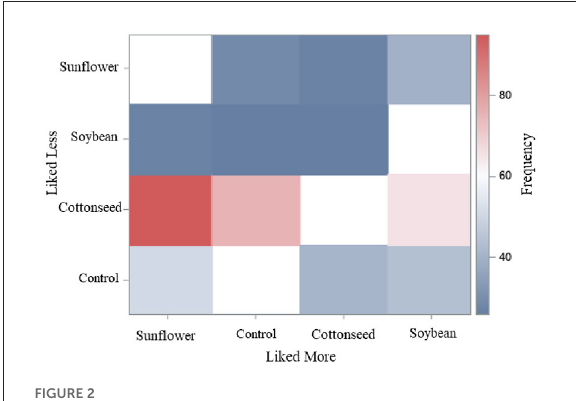
FIGURE2 Heat map with the frequency of responses from judges for global acceptance on sensory analysis of burgers. In the blind test, judges answered which sample liked more and liked less between burgers of steers without or with different oilseed grains sources in diet: control, soybean, cottonseed, and sunflower. The frequency of combined responses among liked more ( x ) and liked less ( y ) is represented by the intensity of colors blue (cold) to red (hot). The absence of color (white) represents the comparison of a diet with